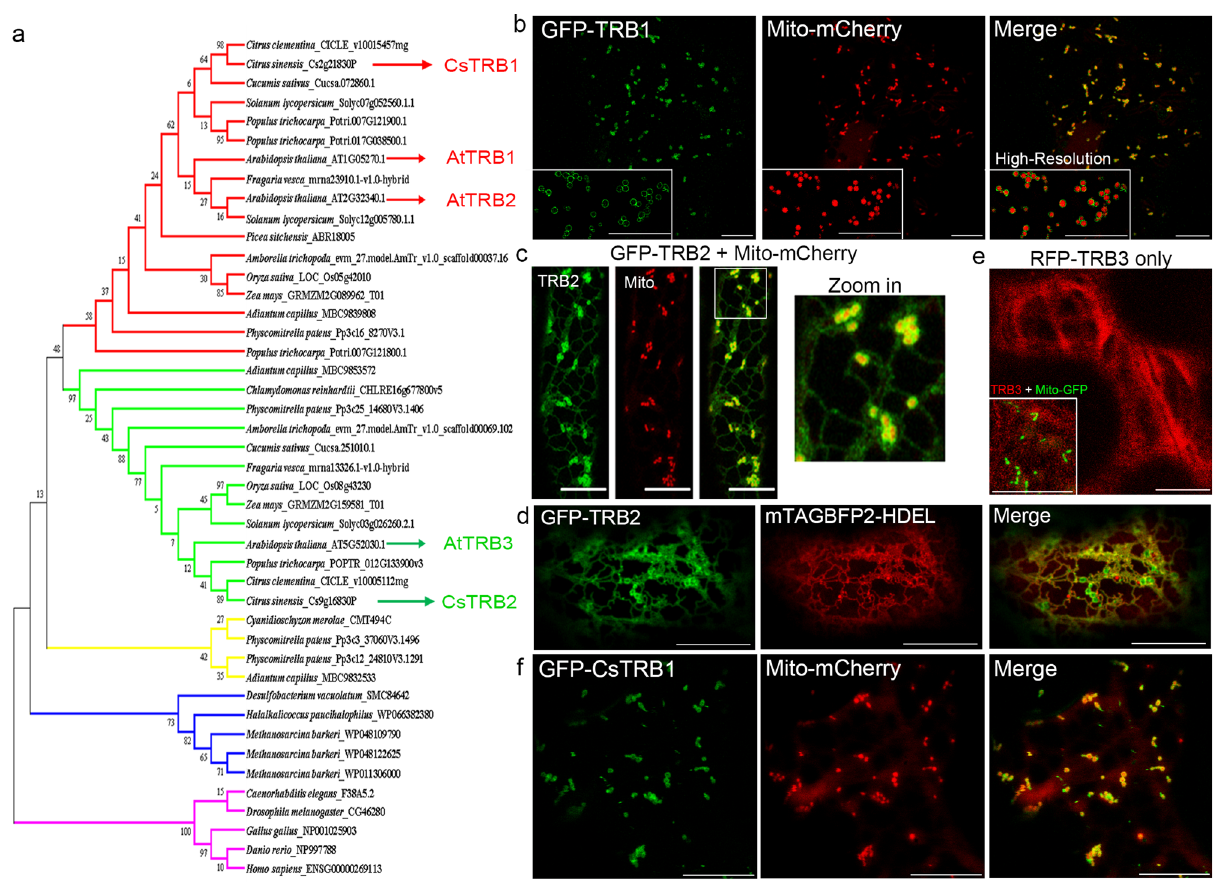
Fig. 2 | Phylogenetically conserved TraB family proteins localise to mito- chondria and ER. a Phylogenetic tree of TraB family homologues showing that Arabidopsis TRB1 and TRB2 originate from the same clade, whereas TRB3 belongs to a separate clade that is more evolutionarily similar to their mammalian homo- logues. b In Arabidopsis, GFP-TRB1 localizes to the outer membrane of mito- chondria that is labelled by the mitochondrial matrix marker, Mito-mCherry. The inset are additional images taken by high-resolution microscopy showing clear